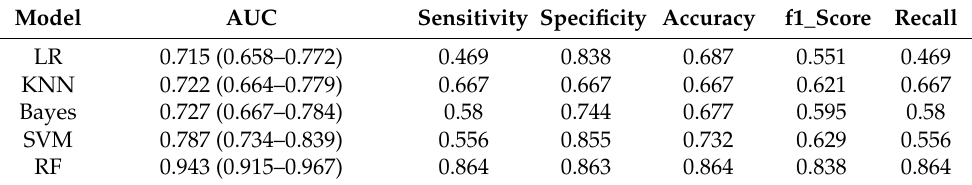
Figure 5. Comparison of five radiomics models based on ten times tenfold cross-validation in internal training group. Box-and-whisker plots of the differences in SVM, RF, LR, KNN and Bayes model among AUC, ACC, Sensitivity and Specificity. RF achieved the best performance in every statistical indicators than other models. The box indicates the 25- and 75- quartile; the horizontal line indicates the median and the cross indicates the mean. Whiskers show the 5- and 95- percentiles; outliers are indicated by circles. Table 3. Model performance of five radiomics models in internal training group.